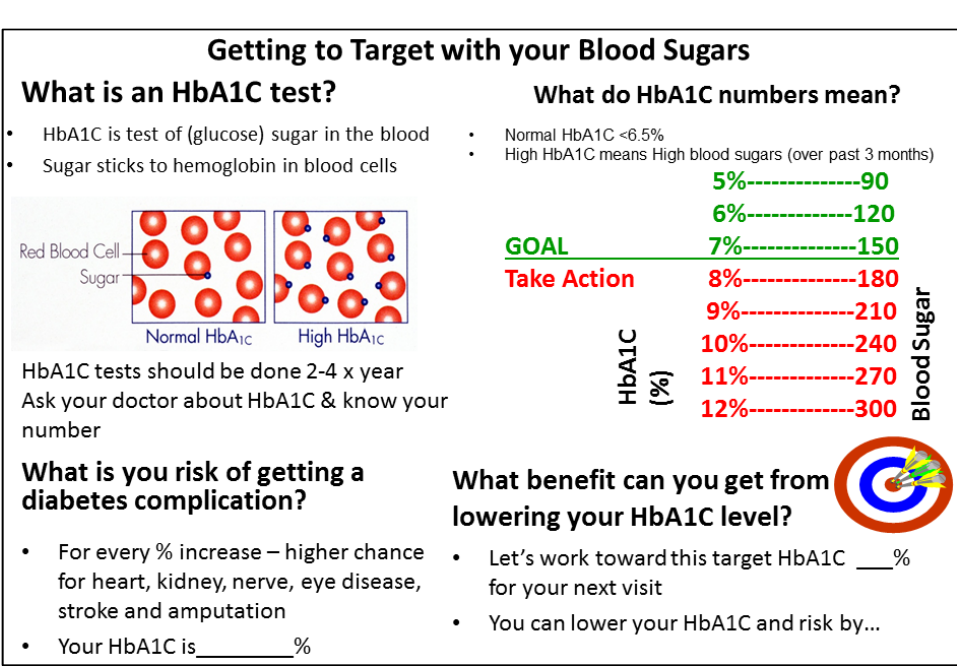
Figure 2. HbA1c decision aid.